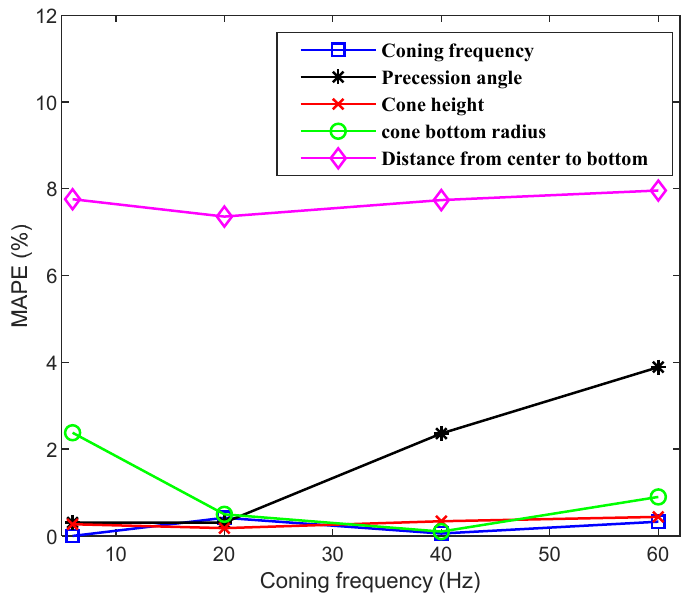
Figure 14. MAPEs of five parameters with different coning frequencies.